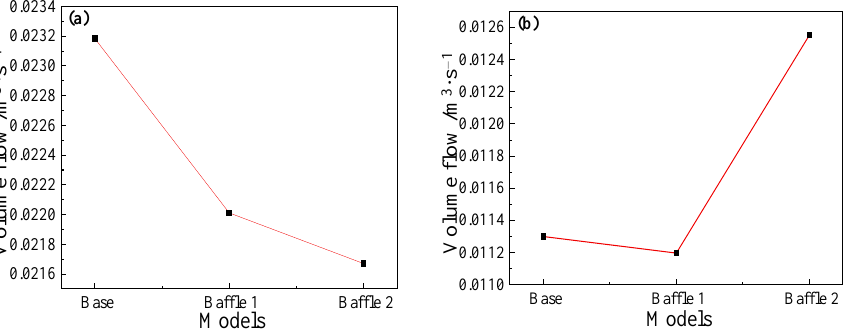
Figure 17. Volume flow at positions ( a ) upstream (5.5 m) and ( b ) downstream (6.6 m) of the baffle for different main troughs.